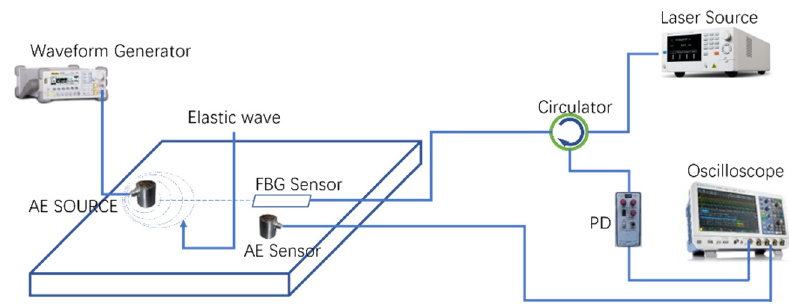
Figure 13. Schematic diagram of AE detection system.